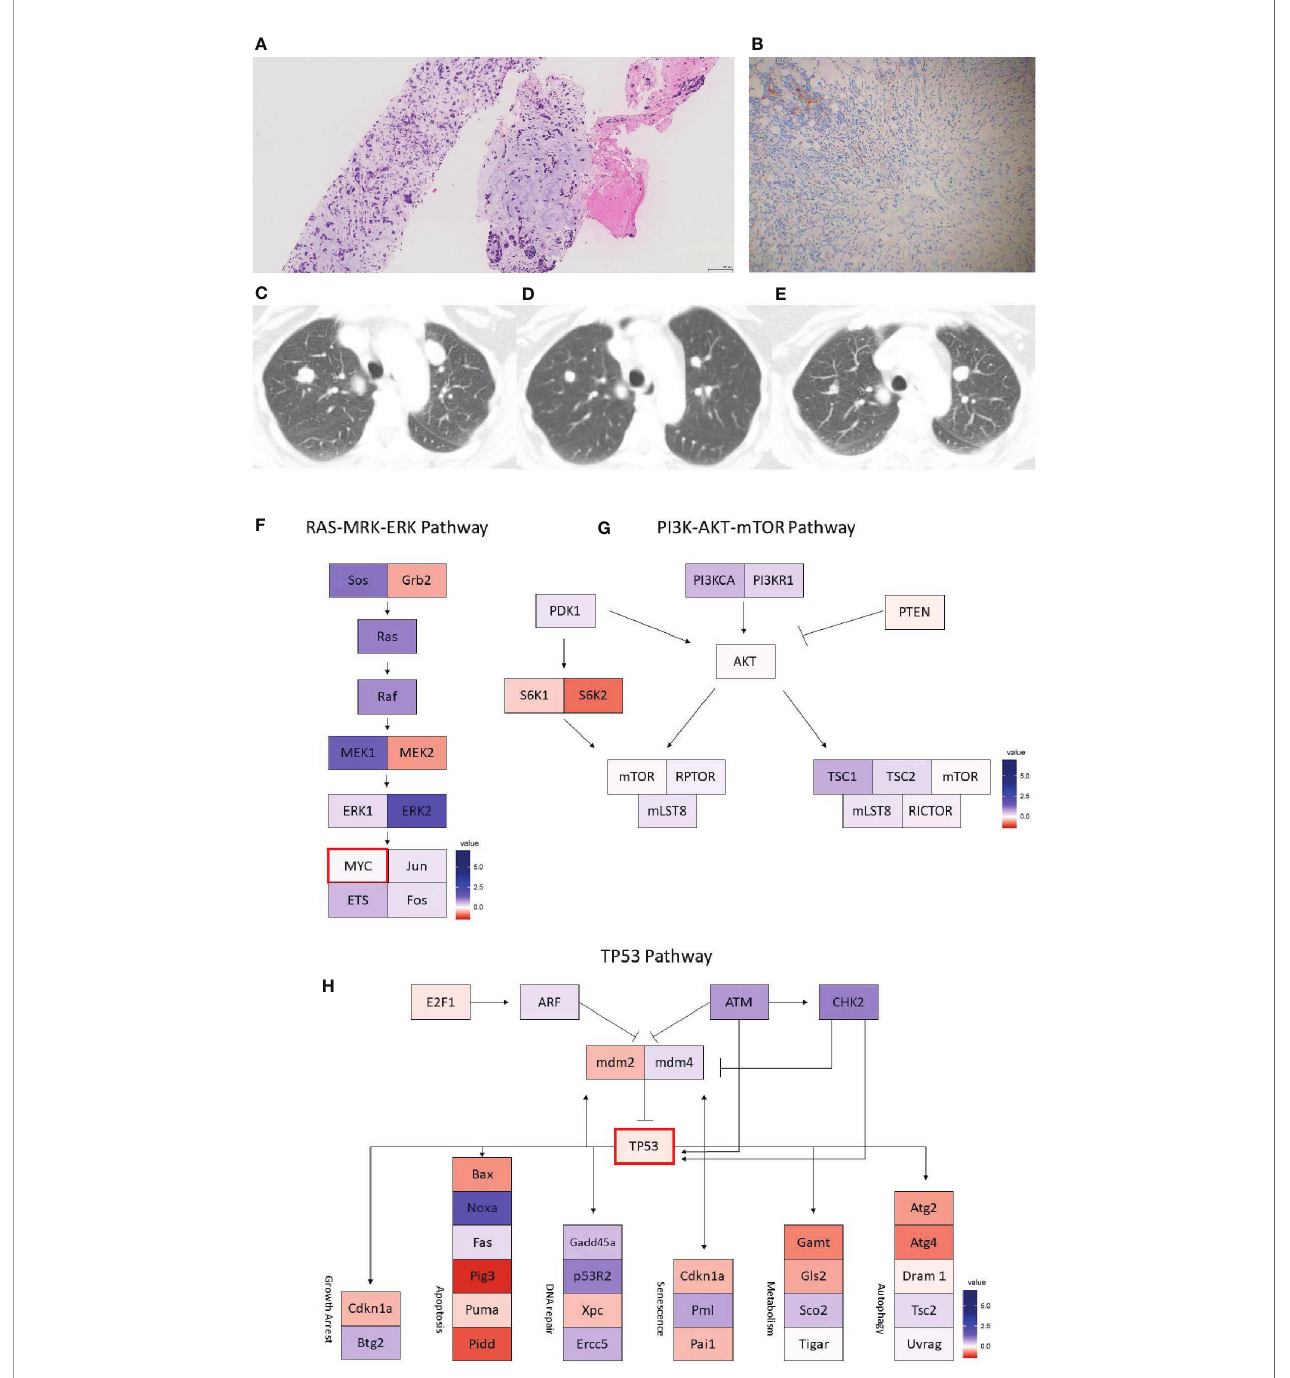
FIGURE 2 | Case 2 (A) H&E image, showing metaplastic squamous carcinoma (B) PD-L1 by the Ventana PD-L1 SP263 assay (C – E) . Radiographic changes from (C) week 0, (D) 12 weeks, and (E) 24 weeks. A mixed, but overall partial response by RECIST criteria is noted initially (D) followed by progression (E) . Images (F – H) show RNA expression heatmaps with modi fi ed z-scores of expression vs. non-metaplastic TNBC cases in pathways of interest for metaplastic breast cancer (F) RAS-MEK-ERK, (G) PI3K-AKT-mTOR (H) TP53. Genes with DNA mutations are outlined in